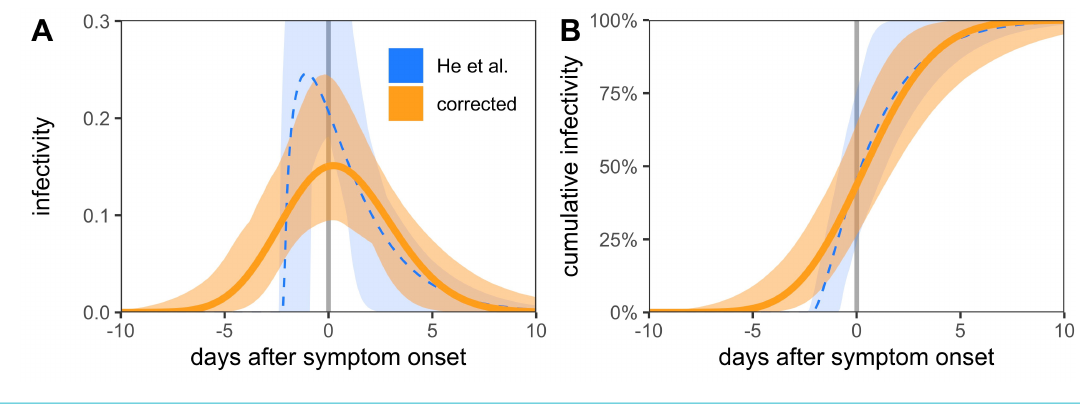
Figure 1: The infectivity profiles extracted from the serial interval data and the log-normally distributed incubation period, as performed in He et al. [1]. Here we used an adaptive grid search to reconstruct the likelihood landscape over the three parameters of the shifted gamma distrib- ution. The confidence intervals are the range of the infectivity profiles that have a likelihood-ratio test statistic within 95% of a χ 2 distribution with 3 degrees of freedom when compared with the maximum likelihood estimate. Panel A shows the probability density function and is analo- gous to figure 1C of He et al. The blue dashed line is the maximum likelihood estimate using the method from He et al. and the solid orange line is the corrected maximum likelihood estimate. Panel B shows the corresponding cumulative density functions.